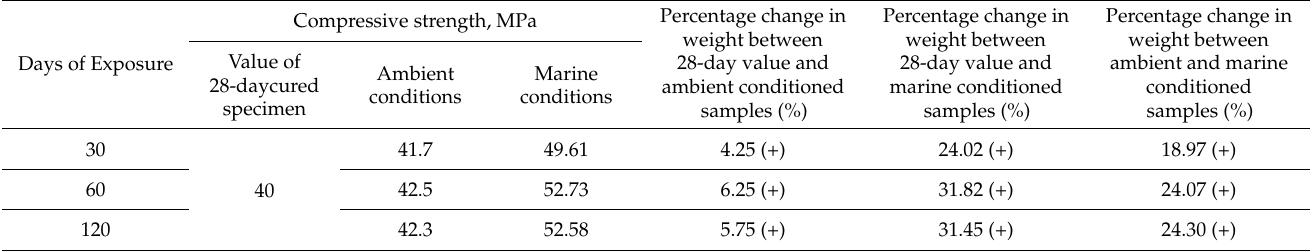
Table 6. Comparison of compressive strength under ambient and marine exposure conditions.